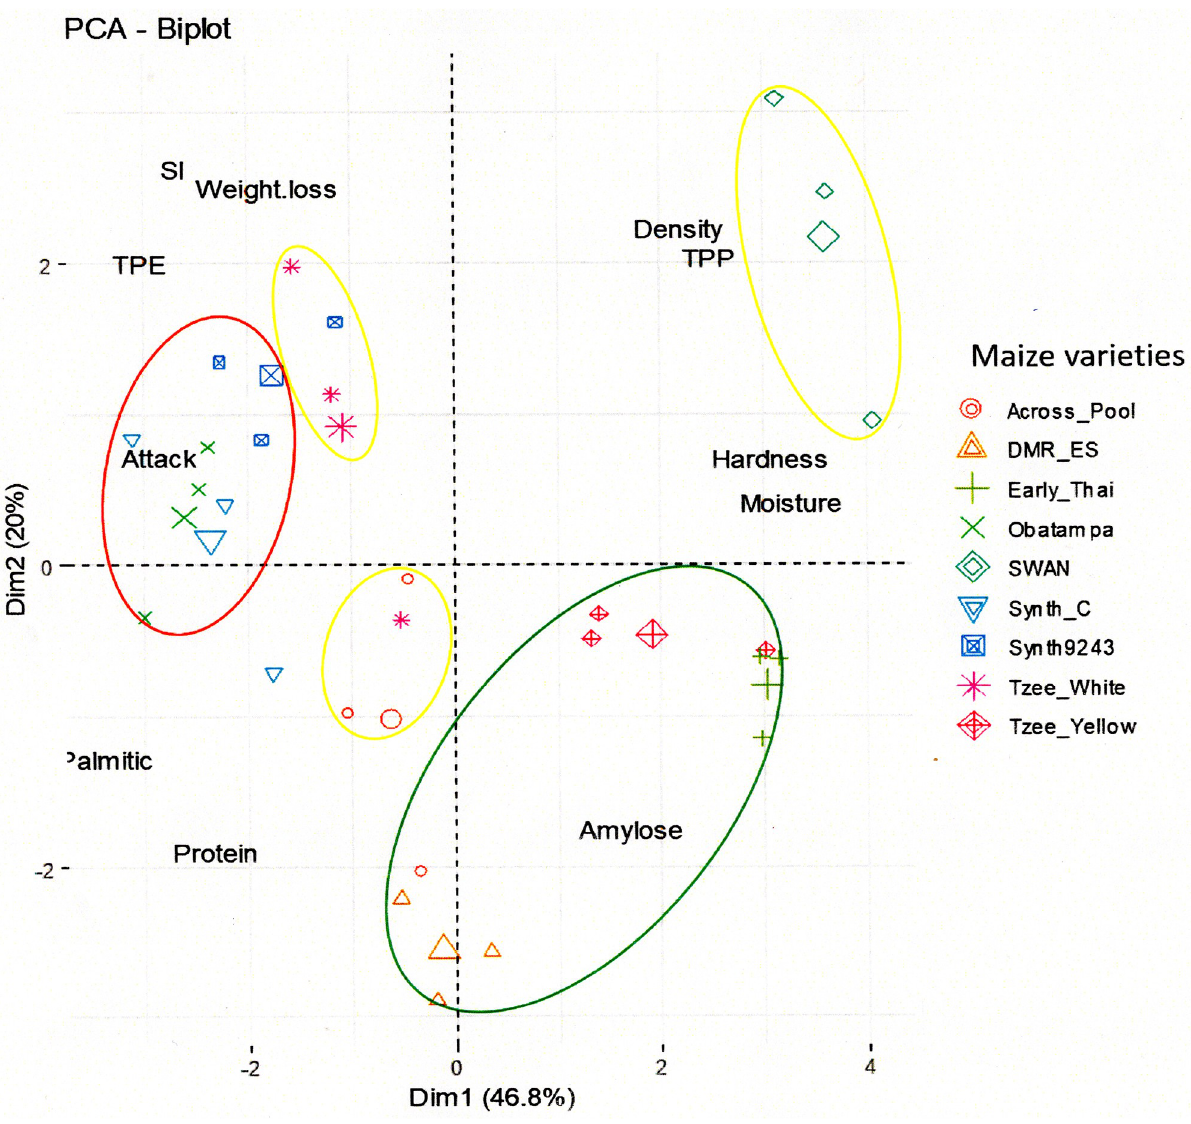
Fig 3. Discrimination of maize varieties by physicochemical and susceptibility parameters (PCA-Biplot). Discrimination of maize varieties (PCA-Biplot) by Discriminant Analysis (DA) on maize susceptibility parameters distribution. The annotation is TPE : Total Progeny Emerged, SI : Susceptibility Index, Attack : Attack percent of maize grains (damage percent), Weight loss : Weight loss percent of maize grains, Moisture : Percentage of grains moisture, TPP : Total Phenolics Content, Palmitic : Percentage of palmitic in grains fatty acids, Protein : Percentage of proteins in grains, Amylose : Percentage of amylose in grains starch, Density : maize grains density, Hardness : maize grains hardness. The susceptibility level of varieties is classified on three groups and indicated by a color gradient; Group_G1: resistant varieties (green circle), Group_G2: moderately resistant varieties (yellow circles) and Group_G3: susceptible varieties (red